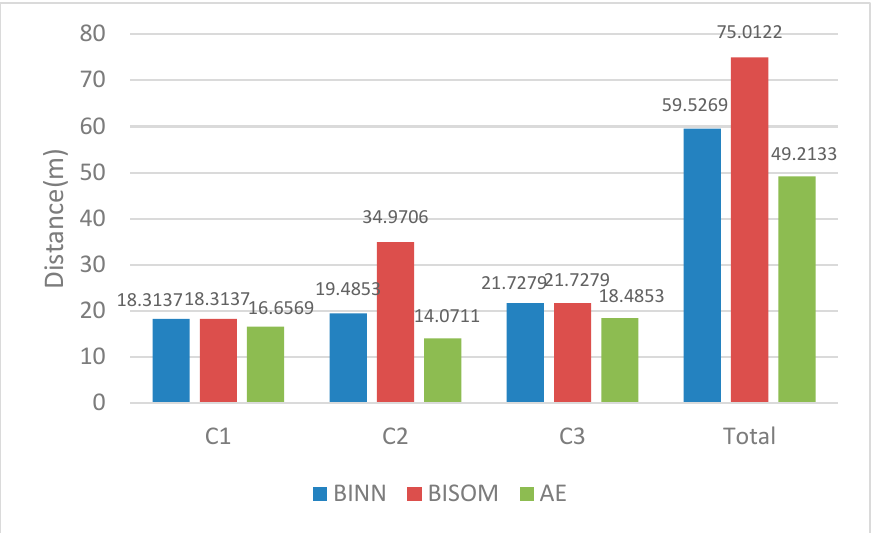
Figure 6. Total distance map of multi-AUVs data acquisition operation.